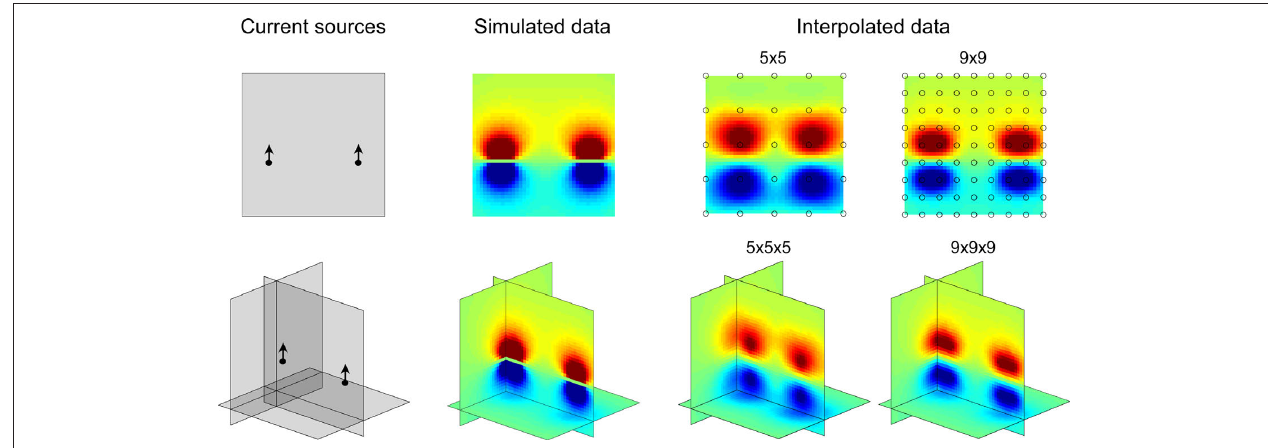
MEAs interpolated on 1681 (2D) or 68921 (3D) points grids and mapped by NeuroMap. The potential field geometry can be estimated by interpolation. Note that the interpolated map is best for highest MEA